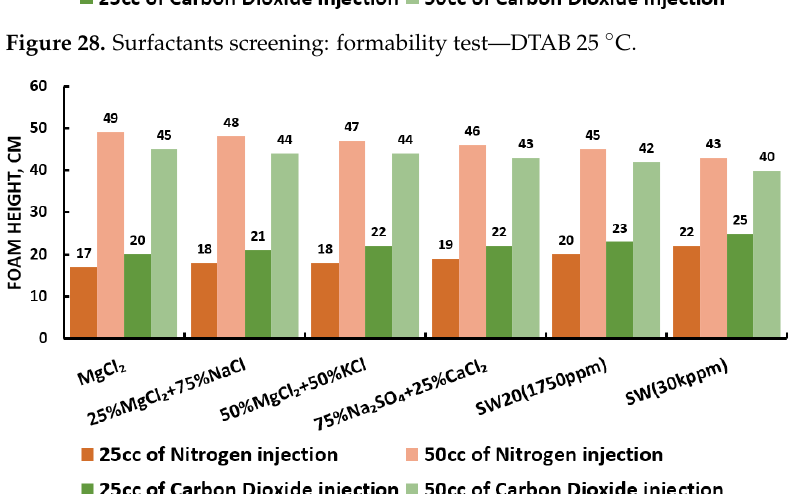
Figure 29. Surfactants screening: formability test—AOS 25 ◦